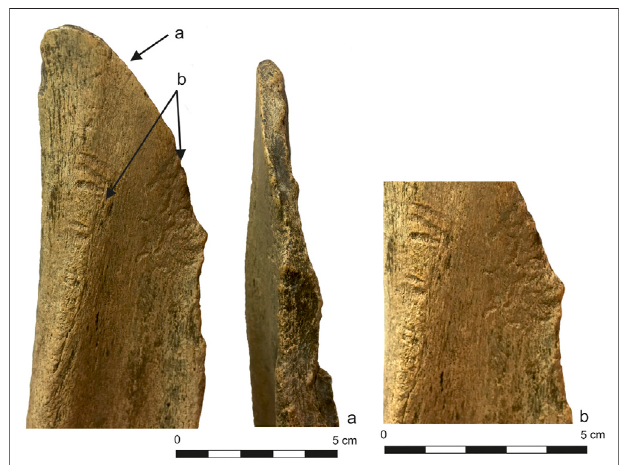
FIGURE 10 | C. knoblochi metacarpal from Tsagaan Agui Cave, Layer 4 exhibiting traces of anthropogenic splitting with hyaena gnawing